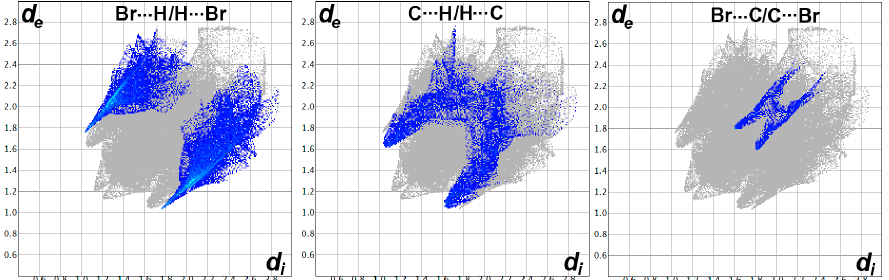
Figure 6. The decomposed fingerprint of the important interactions in the [Cd(BPMT)Br 2 ] complex.